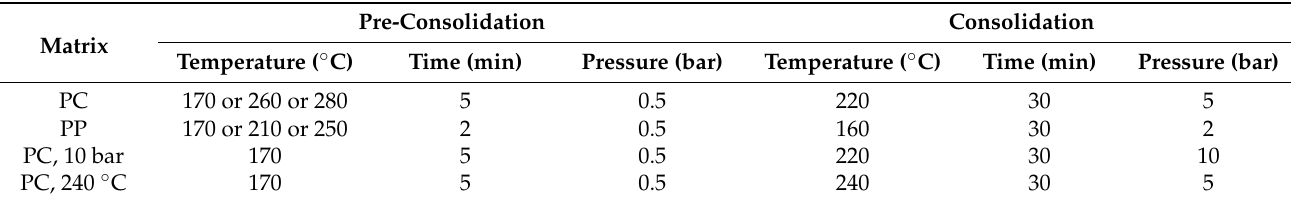
Table 2. Processing parameters for BF-PC and BF-PP